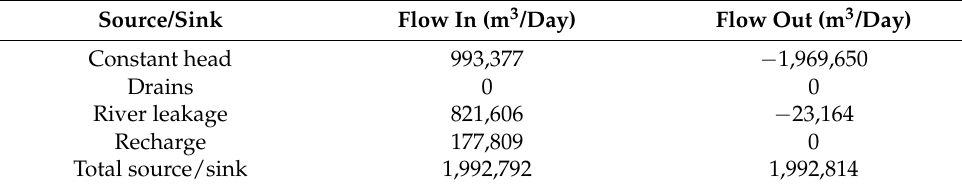
Table 7. Computed groundwater budget for the whole model of the lower Rusizi plain. Source/Sink Flow In (m 3